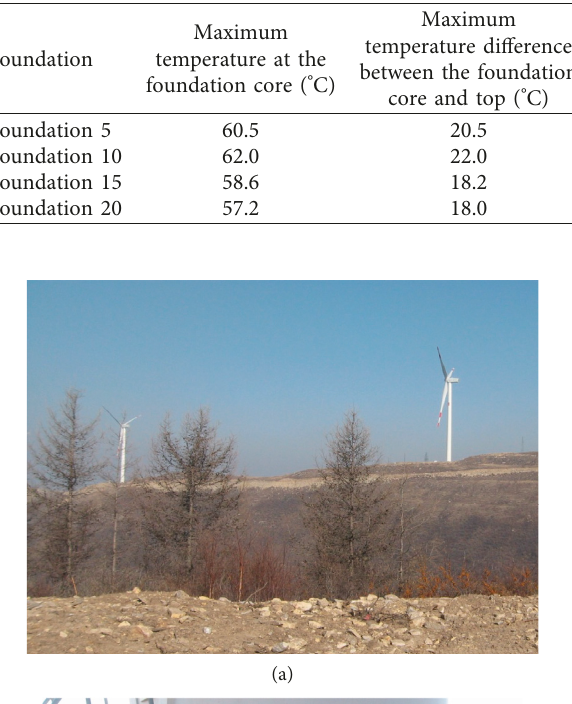
Table 3: Temperature measurement results of representative